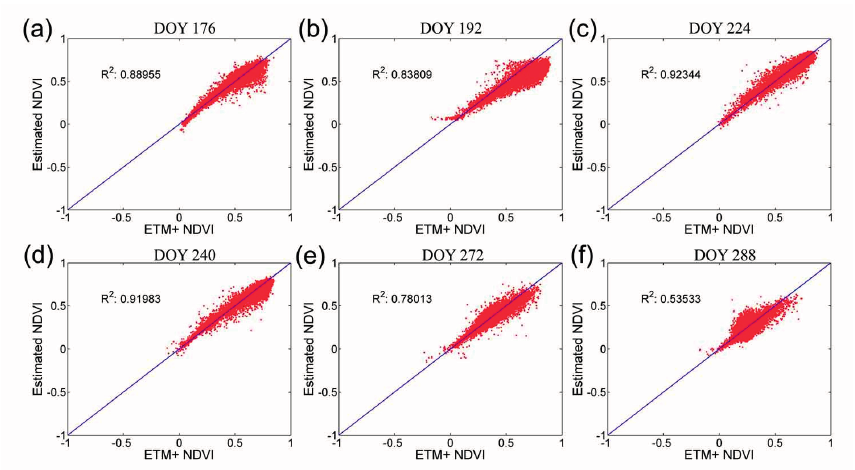
Figure 9. Scatterplots of the predicted NDVI and the actual ETM+ NDVI for the 133_33 sub-area. (Predicted NDVI by blending MODIS and ETM+ data of: ( a ) DOY 112, DOY 192; ( b ) DOY 176, DOY 224; ( c ) DOY 192, DOY 240; ( d ) DOY 224, DOY 272; ( e ) DOY 240, DOY 288; ( f ) DOY 272, DOY 304.